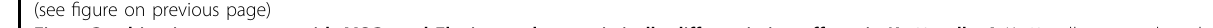
Fig. 4 Combination treatment with MSCs and El triggered synergistically differentiation effects in K562 cells. A K562 cells were cultured alone or co-cultured with MSCs in the presence or absence of different doses of El (0.5 μ M, 1 μ M, and 2 μ M) for 48 h. The relative gene expression of differentiation genes was assessed by RT-qPCR ( n = 3). B Morphological changes in K562 cells that accompanied megakaryocytic differentiation were con fi rmed by Wright – Giemsa staining of cells in the presence and absence of El (0.5 μ M, 1 μ M, and 2 μ M) for 48 h. Scale bars, 50 μ m. C The expression of surface markers CD41 and CD42b of K562 cells was measured by fl ow cytometric analysis and the mean fl uorescence intensity was quanti fi ed. D K562 cells were treated with either MSCs or combination with El for 48 h, the expression levels of megakaryocytic differentiation transcription factors were assessed by RT-qPCR ( n = 3). Data are represented as the mean ± SEM (* P <0.05, ** P <0.01, or *** P <0.001, ns, not signi fi cant, one-way ANOVA was used for multiple comparisons). El